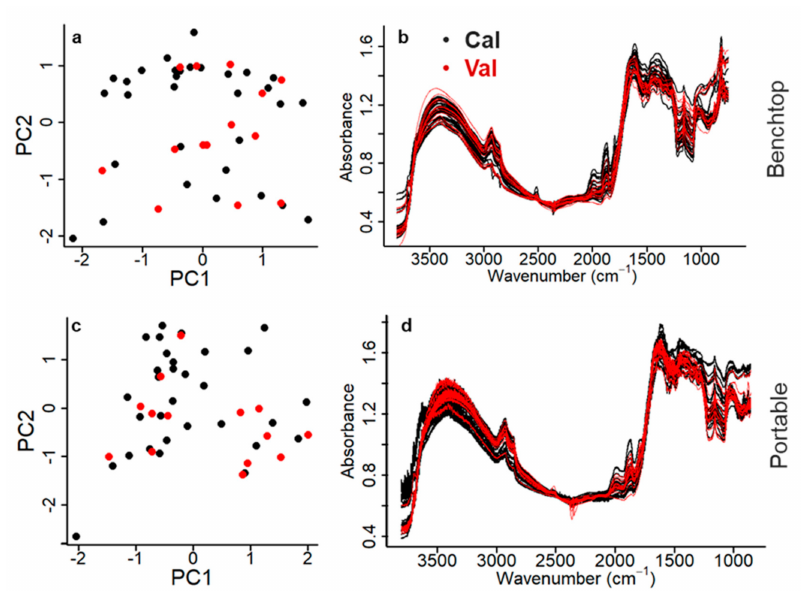
Figure 4. Principal components (PC1 and PC2 scores) of multiplicative scatter correction (MSC)- corrected calibration (black; n = 31) and validation (red; n = 14) samples as selected by k -means sampling and associated MIRS spectra ( a , b ) benchtop MIRS and ( c , d ) portable